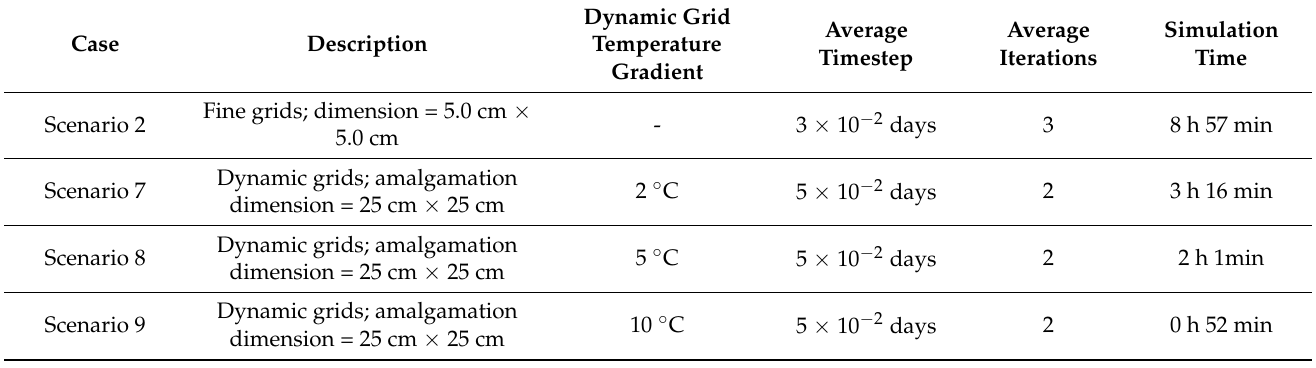
Table 4. Cases of fine grid and dynamic grid scenarios.